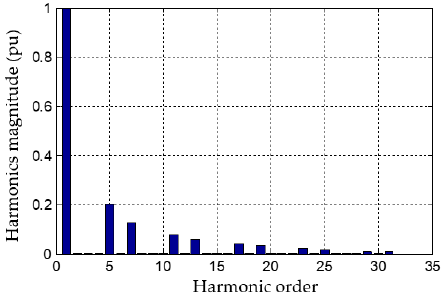
Figure 7. Harmonics spectrum of load current in steady-state regime.